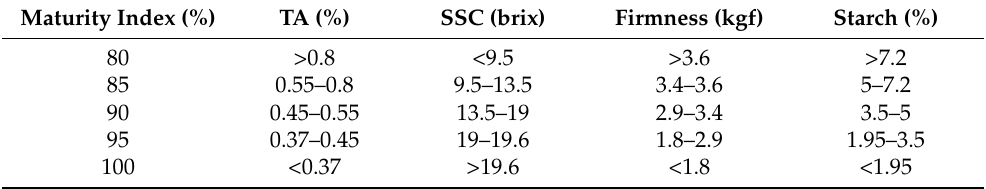
Table 4. Threshold of TA, SSC, firmness, and starch for Arumanis mango maturity index.